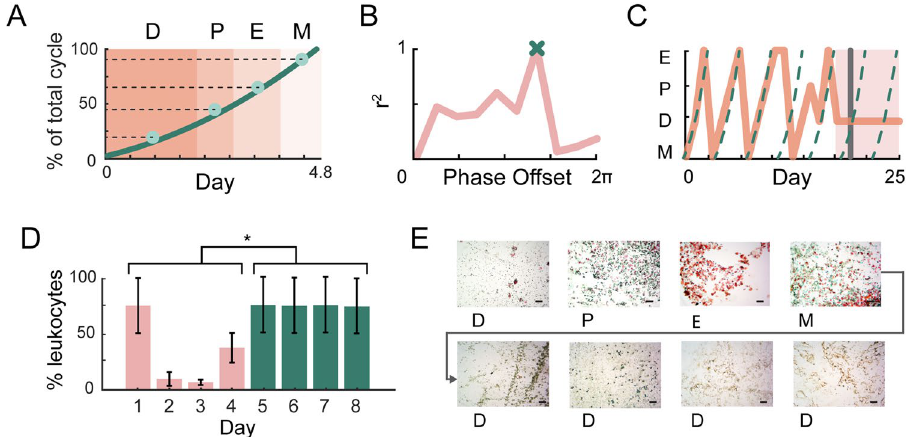
Figure 4. Sequential estrous classifications are fit to an archetypal cycle. ( A ) Schematic of the custom waveform used for temporal cycle fitting. Color blocks indicate the length of each estrous stage as a percentile of average total cycle length, with a curve fitted to the midpoint of each stage across 4.8 days, i.e., the average length of the total cycle ( D diestrus, P proestrus, E estrus, M metestrus; see Methods). Stage lengths are averaged across previous studies 10,18,20–23,30,35–38 . ( B ) Pearson’s coefficient for each iterative fit of the custom waveform to an example 16-day cycle, at increments of 0.1 cycles. The best fit is determined by global maxima, marked by an ‘x’ for this example cycle. ( C ) Example of a naturally cycling mouse tracked across 25 days, with the animal’s cycle shown as a solid orange line and the fitted cycle curve as a dotted teal line. The mouse initially exhibited regular cycles but entered pseudopregnancy on day 18 (shaded area), causing EstrousNet to give the user a pseudopregnancy warning message (grey line). ( D ) Proportion of leukocytes in cytological cell counts before (blue) and after (pink) pseudopregnancy. Mean + / − SE, F (1,6) = 7.44, p = 0.034, as determined by two-way ANOVA. Asterisk indicates significance of p < 0.05. ( E ) Cytology images from a normally cycling mouse entering pseudopregnancy, demonstrating prolonged diestrus, with an abnormally high proportion of leukocytes. Scale bars = 10